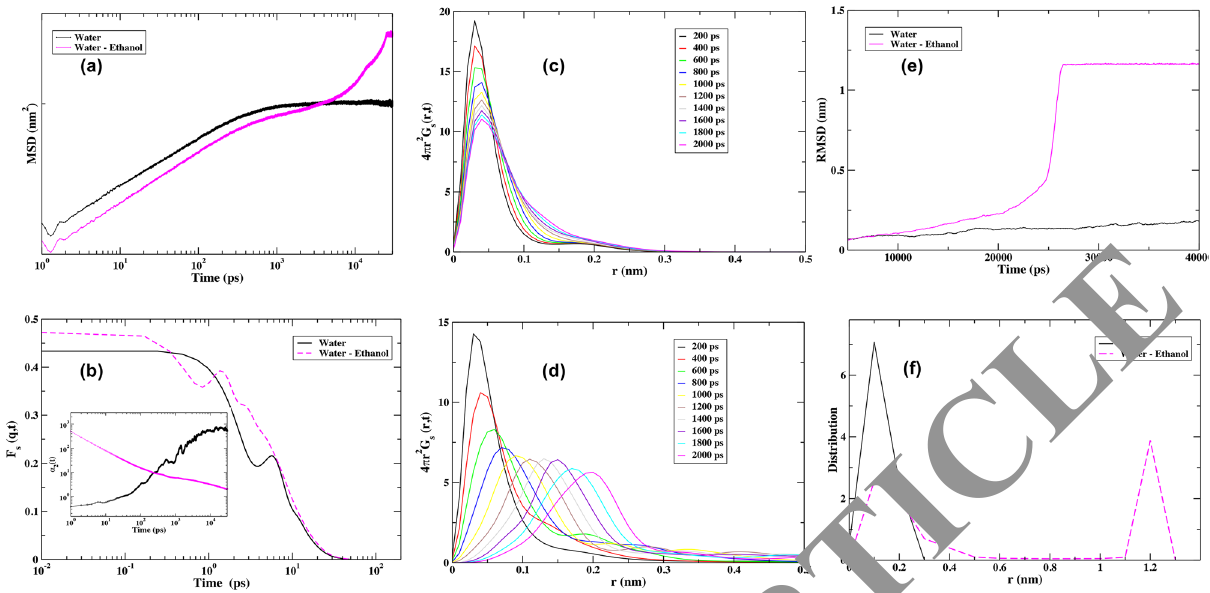
Figure 11. ( a ) The calculated MSD and ( b ) the self ISF from the MD simulation of the IFN - γ receptor complex in water (black) and in a mixed ethanol–water solvent (magenta). The inset in ( b ) shows the plot of the non- Gaussian parameter (α 2 (t)) of the cytokine complex in the two different solvent environments. The van Hove self-correlation function of the IFN - γ complex in (c ) water and ( d ) a water–ethanol mixed solvent from MD simulation. ( e ) A representative RMSD of the IFN - γ receptor complex in water (black line) vs that in the water– ethanol solvent (magenta line). In each of the individual MD simulations carried out on the IFN - γ receptor complex in the water–ethanol solvent, we observed a similar transition in the RMSD. ( f ) The distribution of the C-α distances from the computation of the root mean square deviation of atom distances in the receptor complex from ( e